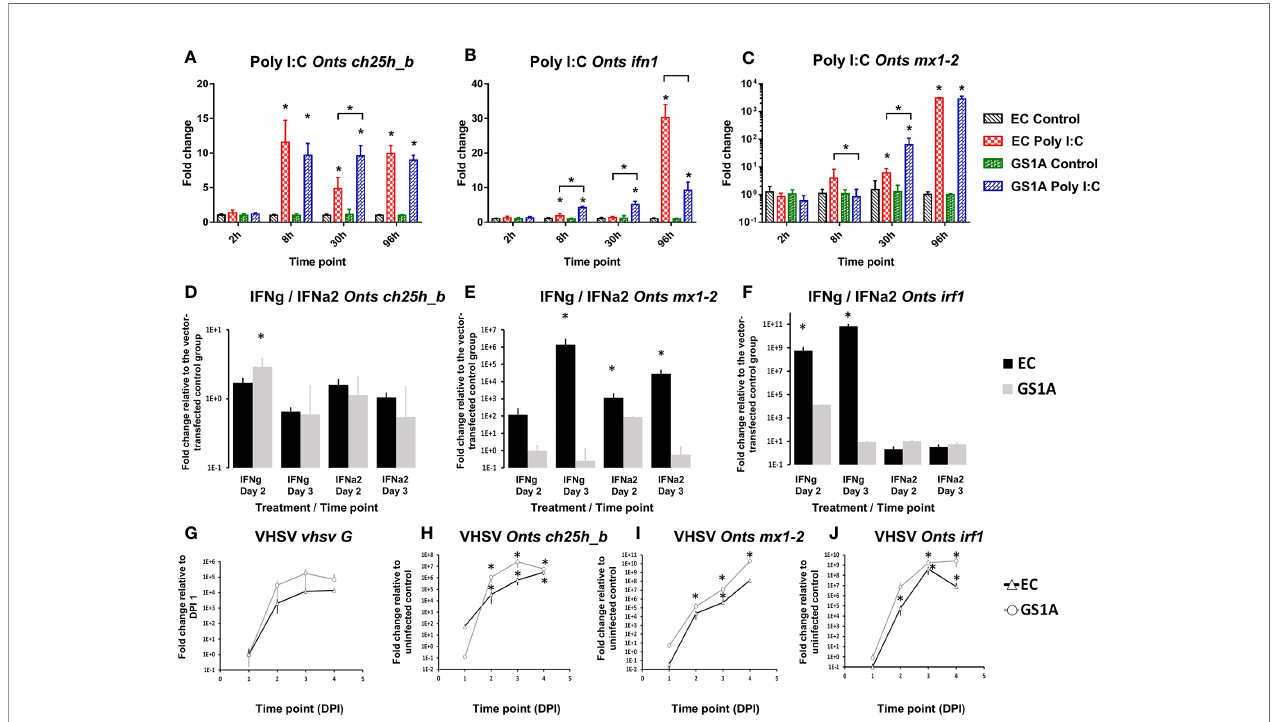
FIGURE 8 | Effect of the stimulation or infection of Chinook salmon cells CHSE-EC and CHSE-GS1A (lacking the ability to produce stat1a1 and stat1a2) on the levels of gene expression. Cells were incubated with poly I:C and the levels of expression of Chinook salmon ( Onts ) ch25h_b (A) , mx1-2 (B) , ifn1 (C) are presented from n = 5 replicates. Next the cells were transfected with IFNa2 (IFN A2) or IFN g (IFNG) expression plasmids and the levels of gene expression of ch25h_b (D) mx1- 2 (E) irf1 (F) measured 2 or 3 days post-transfection from n = 3 replicates. This was followed by infection of the cells with rVHSV-tomato (MOI of 1) and the level of expression for vhsv G (G) ch25h_b (H) mx1-2 (I) irf1 (J) were measured at 1, 2, 3 or 4 days post-infection from n = 3 replicates. Data presented as a bar or line indicating mean fold change (±SD). * indicates a statistically signi fi cant difference at p<0.05 between control and treatment or between different cell lines. Analysis was performed with two-way ANOVA with treatments/cell lines and time points as factors. The ANOVA was followed by subsequent pairwise multiple comparisons using the Holm-Sidak method.